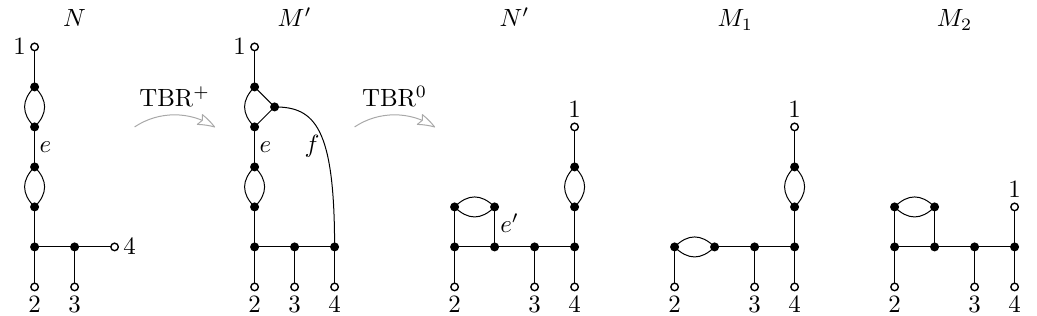
Figure 8: Two networks N, N (cid:48) ∈ u N with TBR-distance two such that there exist a n shortest TBR-sequence from N to N (cid:48) starting with a TBR + move (to M (cid:48) ).